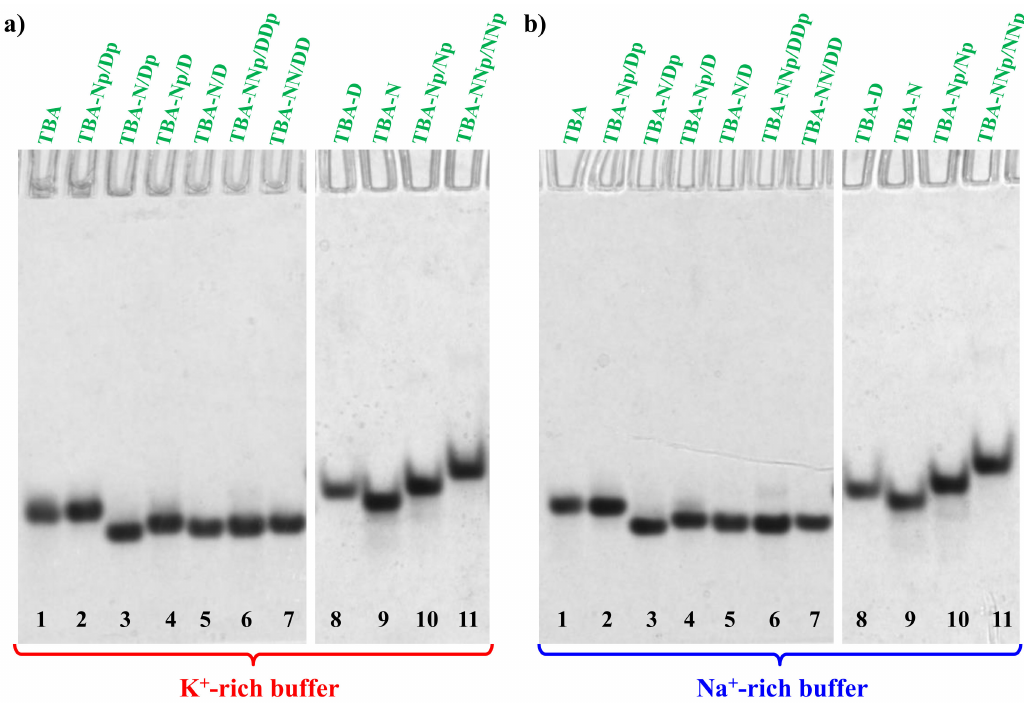
Figure 5. Representative 15% polyacrylamide gel electrophoresis under native conditions of the oligonucleotide samples at 15 µ M in the selected K + -rich ( a ) and Na + -rich ( b ) buffer solutions, run at 80 V at r.t. for 2.5 h in TBE 1X buffer. Lane 1: TBA; lane 2: TBA-Np/Dp ; lane 3: TBA-N/Dp ; lane 4: TBA-Np/D ; lane 5: TBA-N/D ; lane 6: TBA-NNp/DDp ; lane 7: TBA-NN/DD ; lane 8: TBA-D ; lane 9: TBA-N ; lane 10: TBA-Np/Np ; lane 11: TBA-NN/pNNp